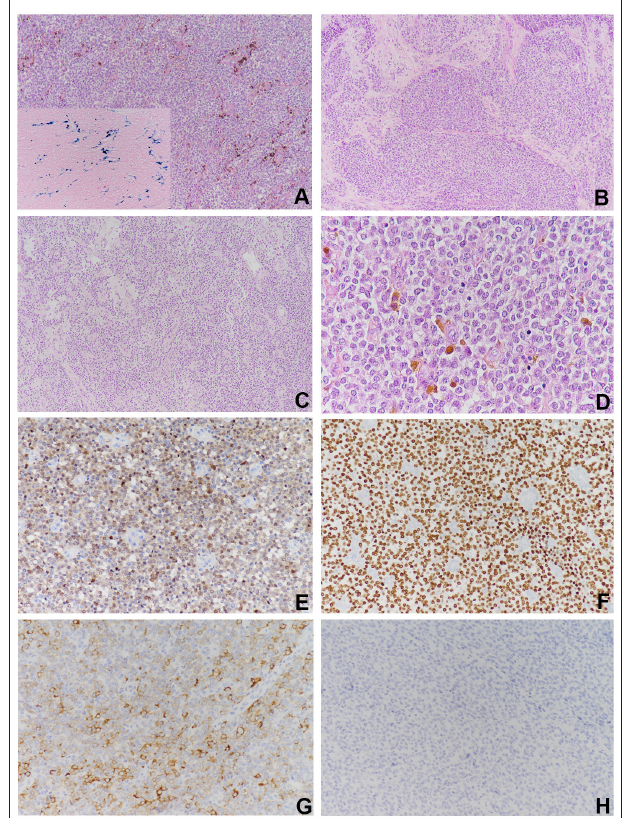
FIGURE 2 | Histological findings and immunohistochemical staining of the cardiac lesion. (A) The neoplastic cells proliferated diffusely in the pattern of nests and sheets with scattered deposition of pigment ( × 100). (B) Fibrous separation was notable ( × 100). (C) Focal areas with remarkable cellular dyscohesion imparted a vague pseudopapillary pattern ( × 100). (D) The tumor cells were small to medium in size with fine chromatin and predominantly pale eosinophilic cytoplasm. The nuclei were typically round to oval with somewhat irregular contours and contained small nucleoli. Cytoplasmic clearing was also observed. The mitotic figures were easily found ( × 400). The tumor cells were strongly and diffusely positive for (E) S100 and (F) SOX10 ( × 100), (G) moderately positive for Syn, and (H) negative for